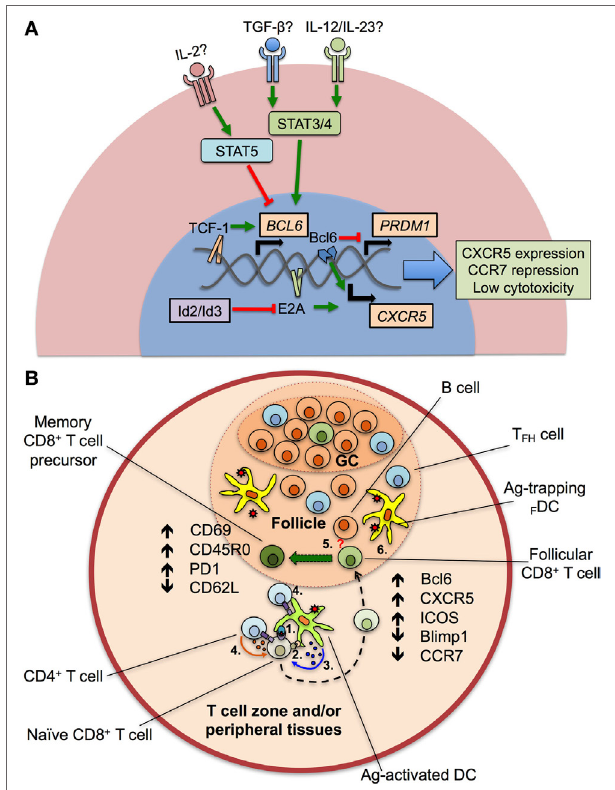
FigURe 1 | Transcriptional program and differentiation of CXCR5 + CD8 + T cells. (A) After the—still to be confirmed—stimulation of transforming growth factor (TGF- β ) plus interleukin (IL)-12 or IL-23, the signal transducer and activator of transcription (STAT) 3 and 4 proteins are activated and induce the expression of BCL6 gene, via the binding of the Transcription Factor 1 (TCF-1) to its promoter. TCF-1, together with the B cell lymphoma (Bcl) 6 transcription factor also represses the expression of the PRDM1 gene, which codifies for the Blimp1 protein. E2A protein, regulated by the inhibitors of differentiation (Id)2 and Id3 proteins, aided by Bcl6, upregulates the chemokine receptor CXCR5, and downregulates CCR7 and cytotoxic activity. Apparently, IL-2, through STAT5 signaling, potently suppresses the expression of BCL6 gene and the differentiation of CXCR5 + CD8 + T cells. (B) After antigen (Ag) processing in T cell zones and/or peripheral tissues, dendritic cells (DCs) present peptides to naïve CD8 + T cells via class I major histocompatibility complex–T cell receptor interaction (1). Ag-activated DCs also provide costimulatory signals (such as CD80/CD86 binding to CD28) (2) and secrete cytokines that drive the differentiation of CXCR5 + CD8 + T cells (3). The help of CD4 + T cells through CD40L–CD40 interaction and cytokine production could be also required (4). Later, differentiating CD8 + T cells migrate into the lymphoid follicle and germinal center (GC) and begin to express Bcl6, CXCR5, inducible costimulator (ICOS) and suppress Blimp1 and CCR7. Aided by the potential stimulation of differentiating CD8 + T cells by B cells (5, question mark) and Ag persistence (6), CXCR5 + CD8 + T cells fully differentiate and acquire an activated, memory T cell-like phenotype, with high expression of CD69, CD45RO, programmed death (PD)-1, and low